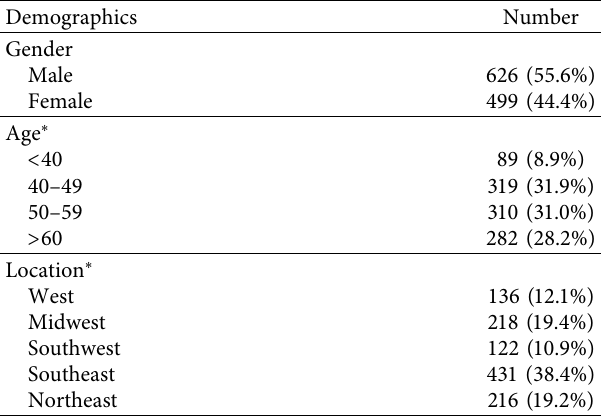
Table 1: Demographics of ophthalmologists included in analysis.